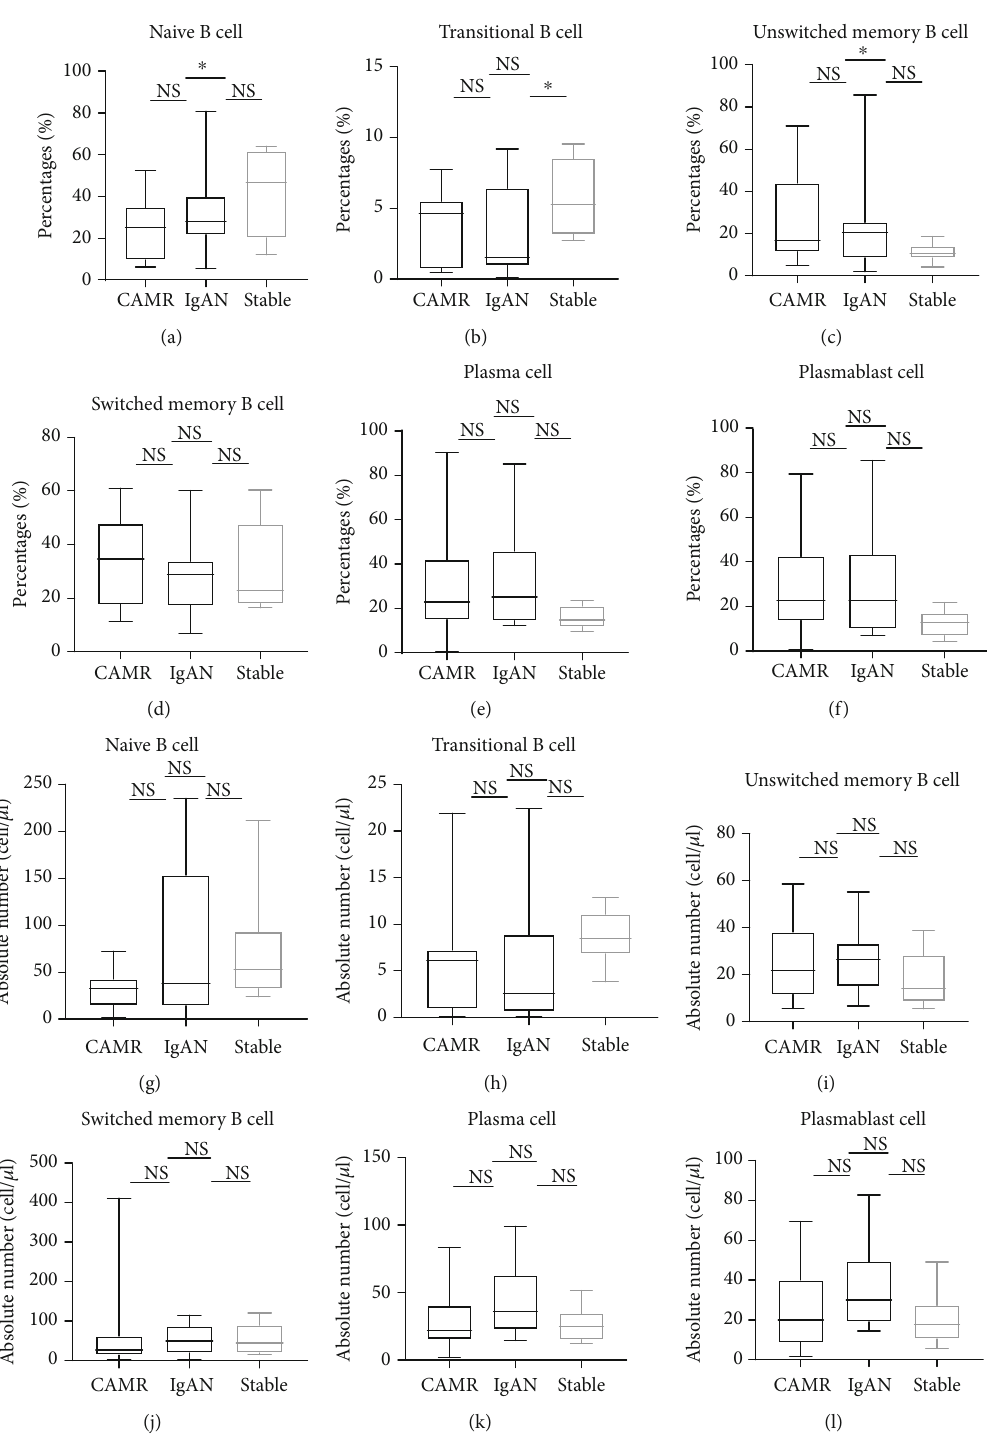
Figure 3: B cell di ff erentiation subsets in patients with CAMR, recurrent de novo IgAN, and stable renal function. Percentages of (a) naïve B cells, (b) transitional B cells, (c) unswitched memory B cells, (d) switched memory B cells, (e) plasma cells, and (f) plasmablasts. Absolute numbers of (g) naïve B cells, (h) transitional B cells, (i) unswitched memory B cells, (j) switched memory B cells, (k) plasma cells, and (l)